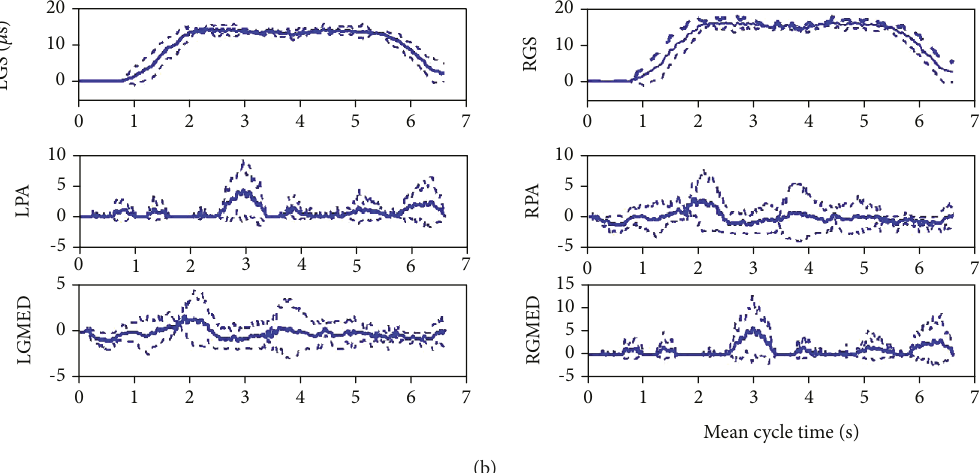
Figure 5: Mean changes across the fi ve trials in (a) the overall CoP position and (b) muscle stimulation pulse widths as posture was shifted in the forward direction. In (a), the mean CoP pro fi les are presented for the anterior-posterior (AP) direction and the medial-lateral (ML) direction. In (b), the changes in stimulation PWs are presented for the following muscles: LGS (left gastrocnemius), RGS (right gastrocnemius), LTA (left tibialis anterior), RTA (right tibialis anterior), LGMED (left gluteus medius), RGMED (right gluteus medius), LPA (left posterior adductor), and RPA (right posterior adductor). In all plots of the repetitions in the forward direction, the mean pro fi les are indicated with bold solid lines and ( ± 1) standard deviation is indicated with dashed